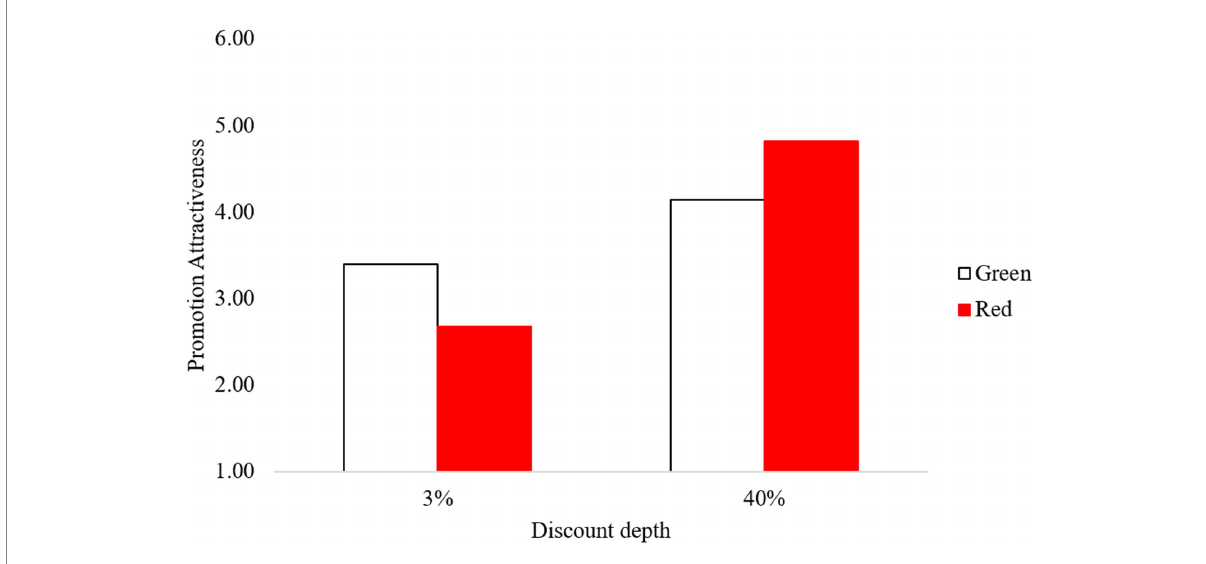
FIGURE 2 Promotion attractiveness as a function of font color and discount